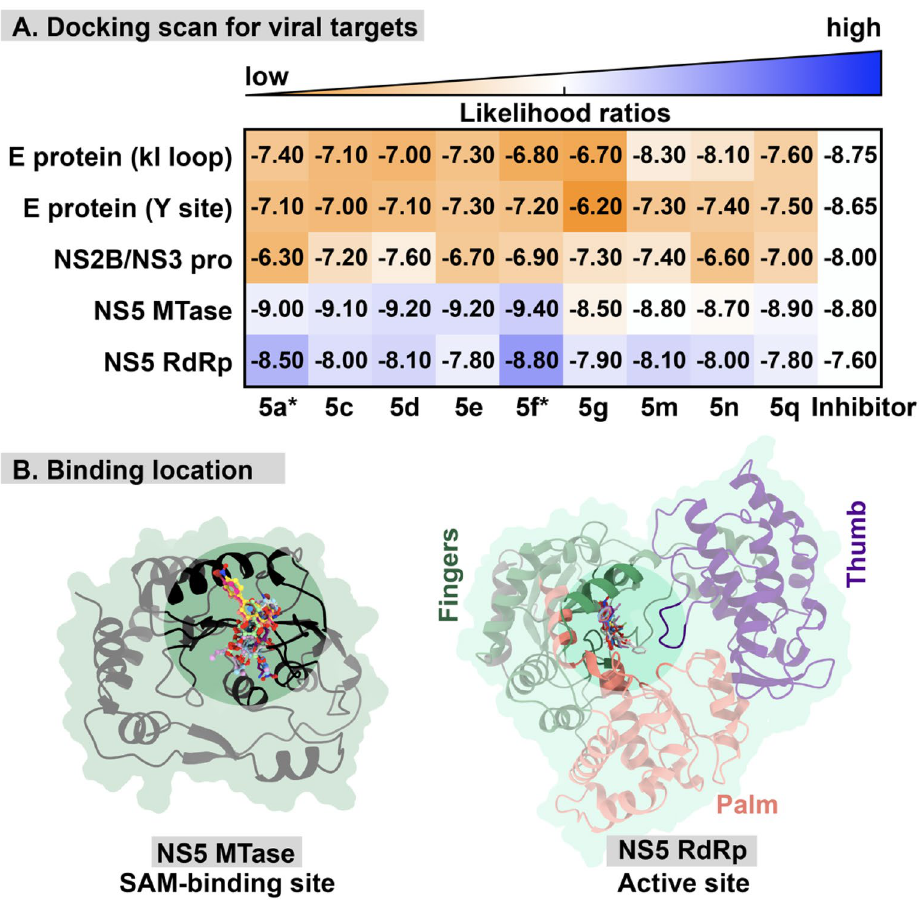
Figure 5. ( A ) Molecular docking scanning result of the potent flavone analogs against that viral promising target protein was plotted versus the native inhibitor of each protein. The color in the grid plot corresponds to the likelihood of the compound targeting a viral protein that ranges from low to high (orange-white-blue) using the known inhibitor as reference data (white). ( B ) The binding location for flavones on NS5 MTase and NS5 RdRp. Note that the molecular result of 5a and 5f were derived from our previous study 19